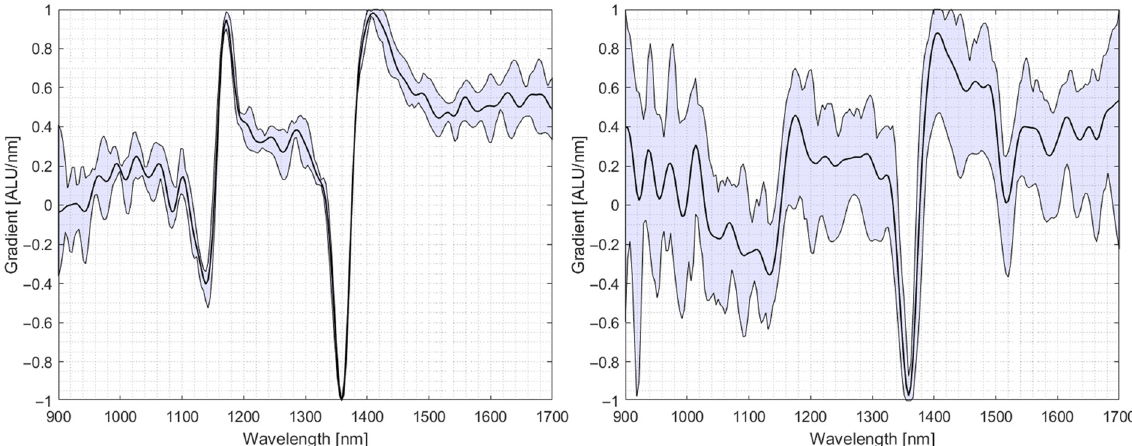
Figure 3. Comparison of spectral variability and characteristic peaks of a PE film when measured in transflection ( left ) and measured in reflectance ( right ).